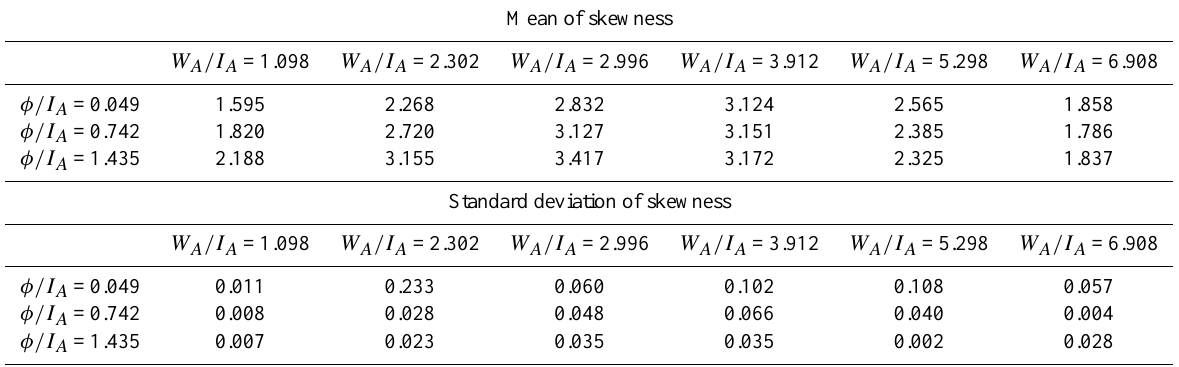
Table 6. Mean and standard deviation of skewness for r L =0.1, r H =0.6; A ranges from 10 to 500km 2 and I 1 ranges from 10 to 50mmh − 1 . Mean of